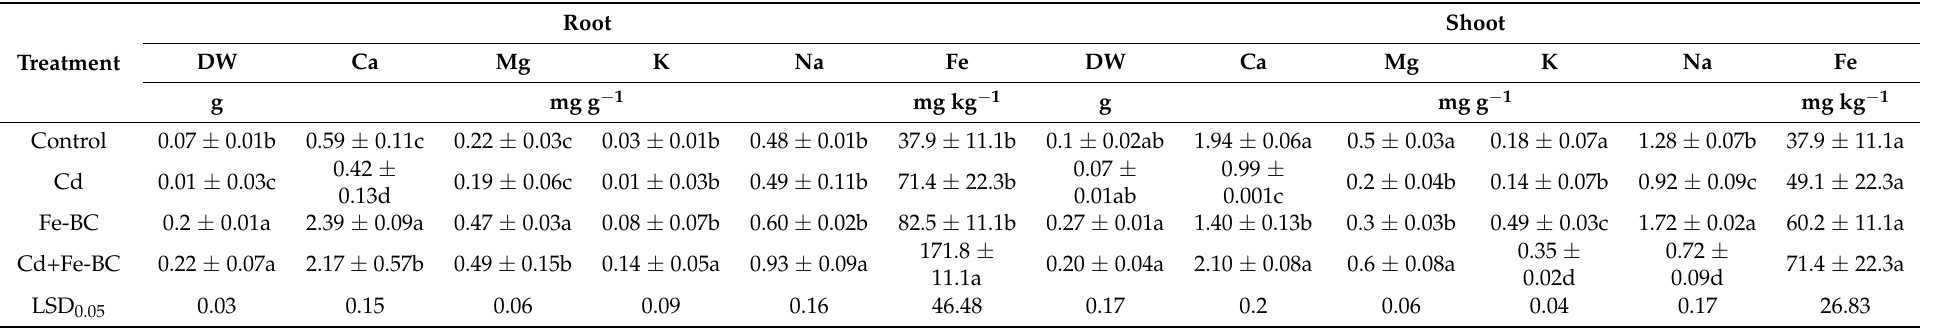
Table 1. Status of macro- and micronutrients in root/shoot of radish cultivar under different treatments (control; Cd; Fe-biochar (BC); Cd+ Fe-BC). Concentrations of sodium (Na), calcium (Ca), potassium (K), and iron (Fe) were determined from both root and shoot of radish cultivar after harvesting. Root Shoot Treatment